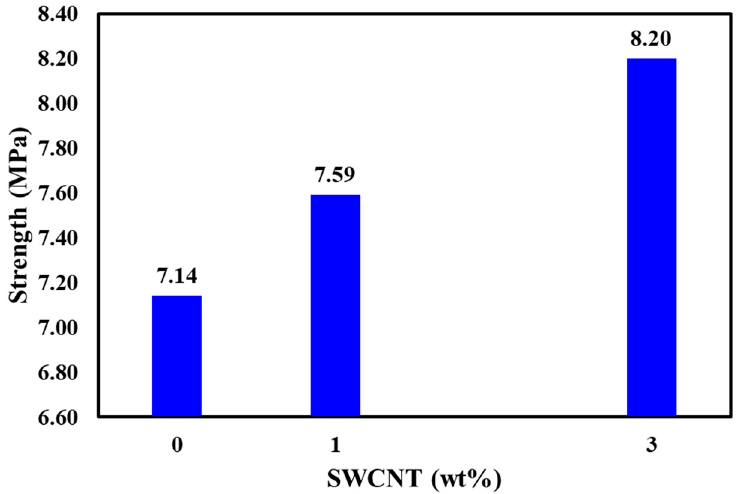
Figure 4. Average value of peeling strength to separate polypropylene from nano-engineered carbon fibers for the four developed CF structures with different loading percentages of 0, 1, and 3 wt% for single-walled carbon nanotubes after a 15% strain in the z -direction.